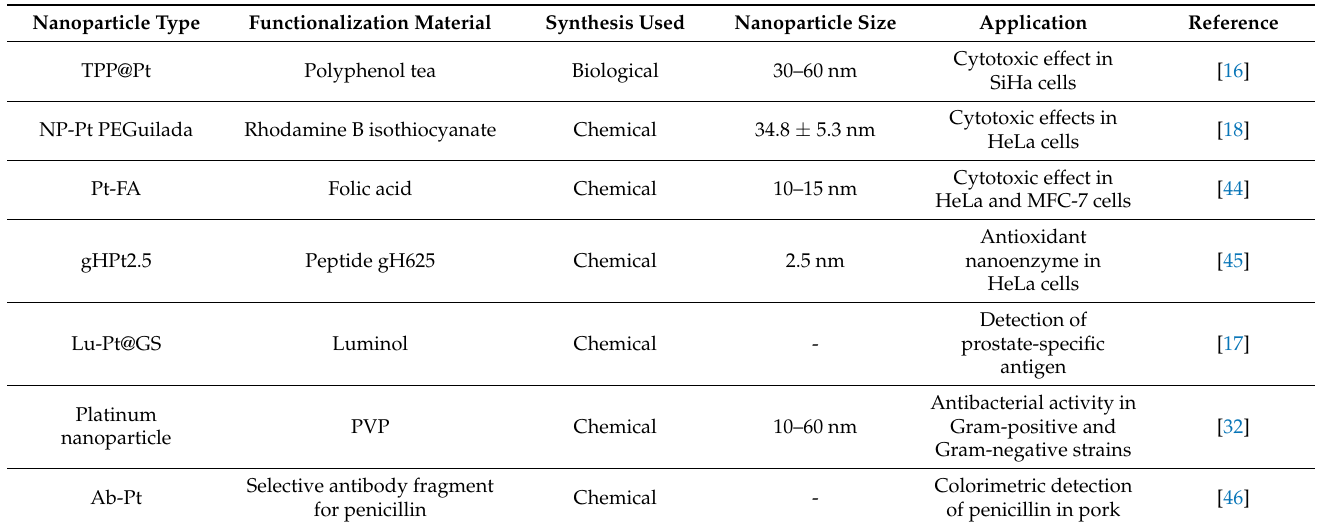
Table 1. Biomedical applications of functionalized